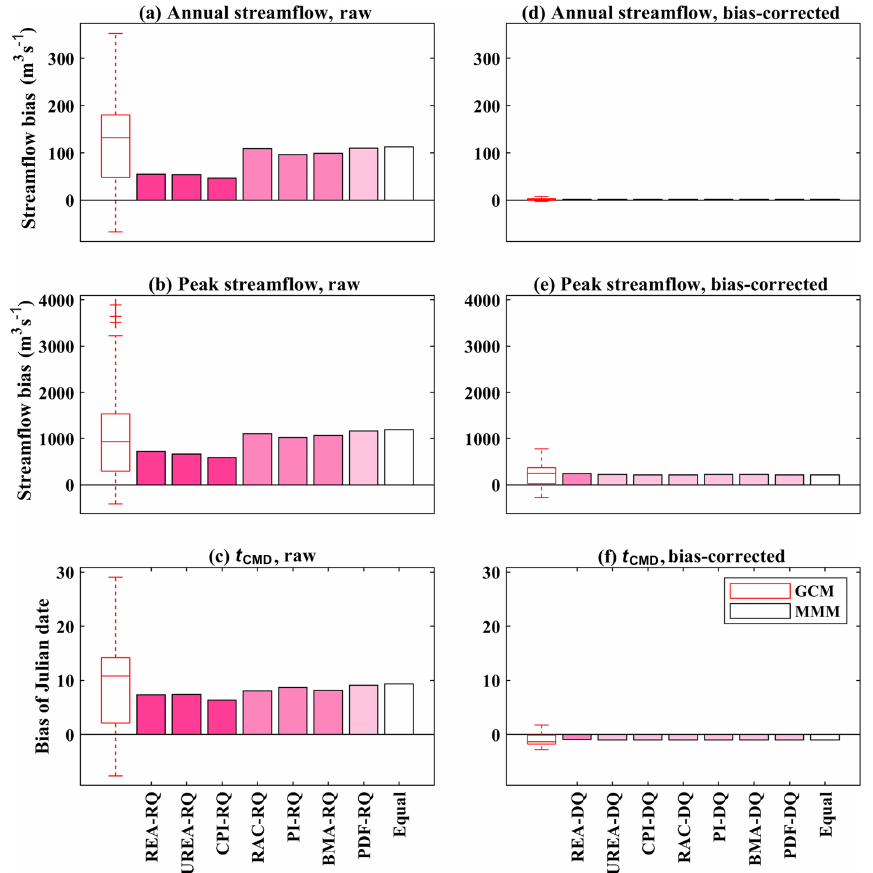
Figure 6. The same as Fig. 5 but for the Manicouagan-5